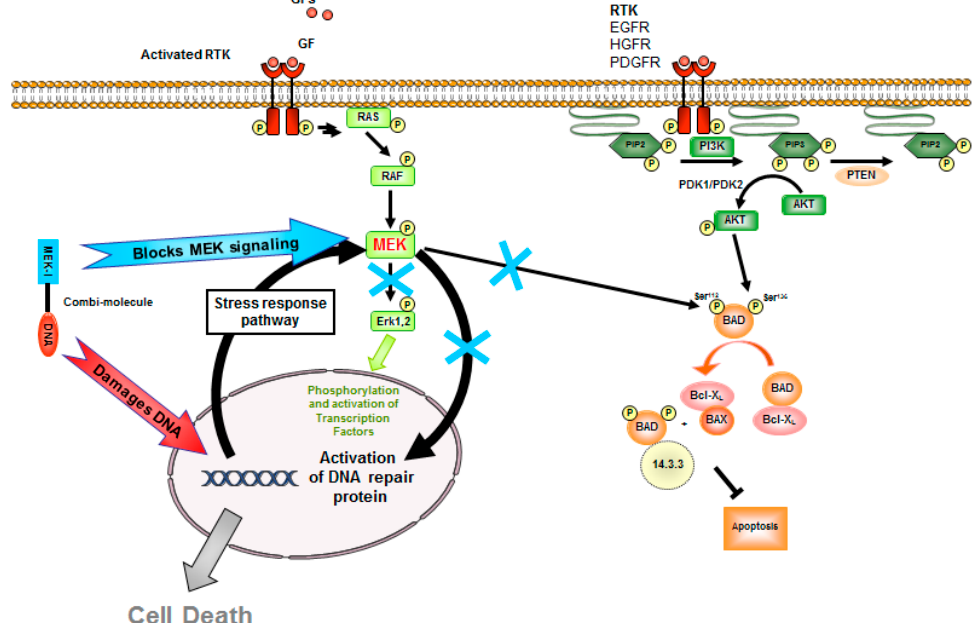
Figure 1. Multiple cell signaling pathways leading to MEK activation. GF: Growth Factor, RTK: Receptor Tyrosine Kinase.